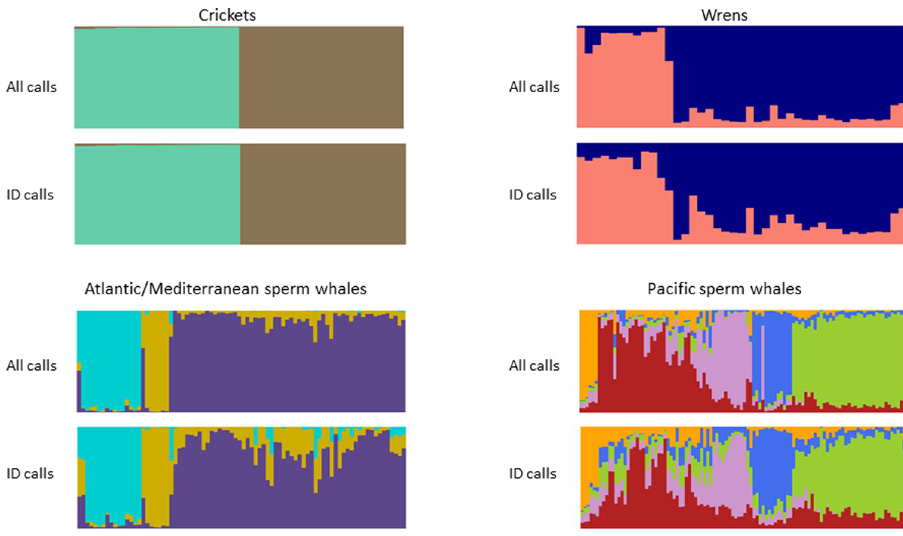
Fig 7. Stacked barplots showing posterior probability distributions of repertoires to identity clades using all calls (above) and just identity calls (below) for the four example data sets.